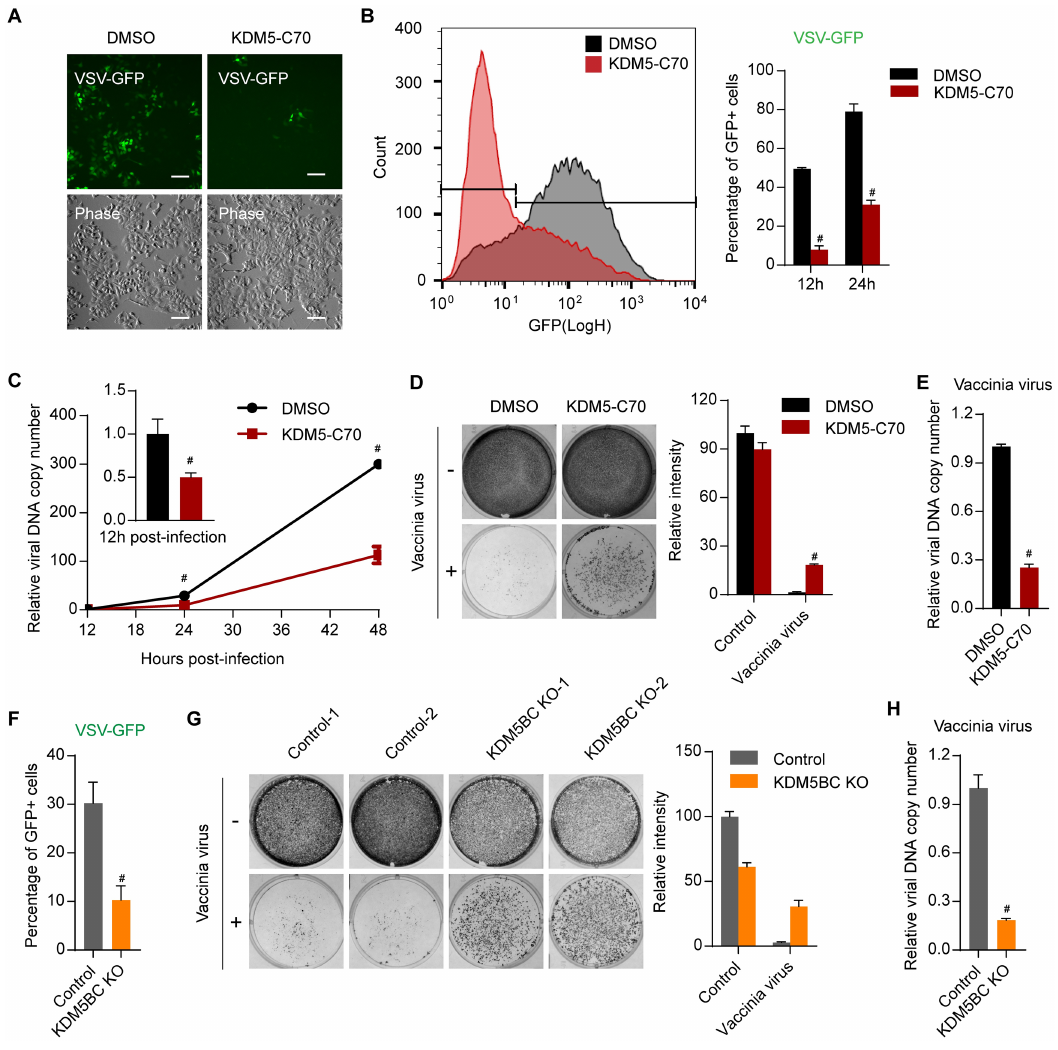
Fig 2. Inhibition of KDM5 demethylases primes the innate antiviral immune response. (A) Representative images of MCF7 cells 24 hours after infection with VSV-GFP viruses at MOI 0.5. Scale bar, 100 μ m. (B) Flow cytometry plot (left panel, 24 hours) and quantification of GFP-positive cells (right panel) after infection with VSV-GFP virus for the indicated time at MOI 0.5. (C) qPCR analysis of DNA copy number of vaccinia virus in MCF7 cells at the indicated time after infection at MOI 0.25. (D) Representative crystal violet staining images (left panel) and quantification of relative intensity (right panel) of MCF7 cells 3 days after infection with vaccinia virus at MOI 0.5. (E) qPCR analysis of DNA copy number of vaccinia virus in growth media from the cells shown in panel D. (F) Quantification of flow cytometry analysis for the percentage of GFP-positive cells in control or KDM5B and KDM5C double knockout cells 12 hours after infection with VSV-GFP virus at MOI 0.5. (G) Representative crystal violet staining images (left panel) and quantification of relative intensity (right panel) of the indicated MCF7 knockout cells 3 days after infection with vaccinia virus at MOI 0.25. (H) qPCR analysis of DNA copy number of vaccinia virus in growth media from the cells shown in panel G. Cells were pretreated with DMSO or 1 μM KDM5-C70 for 5 days, followed by no treatment for 1 day, before viral infection in panel A–E. Representative data from triplicate experiments are shown in panel C, E, F, and H. Two or 3 biological replicates are shown in panel B, D, and G. Error bar denotes SEM. # p < 0.01. The numerical values used to generate graphs in B–H are available in S1 Data. MOI, multiplicity of infection; qPCR, quantitative PCR; VSV-GFP, vesicular stomatitis virus carrying a green fluorescent protein reporter.